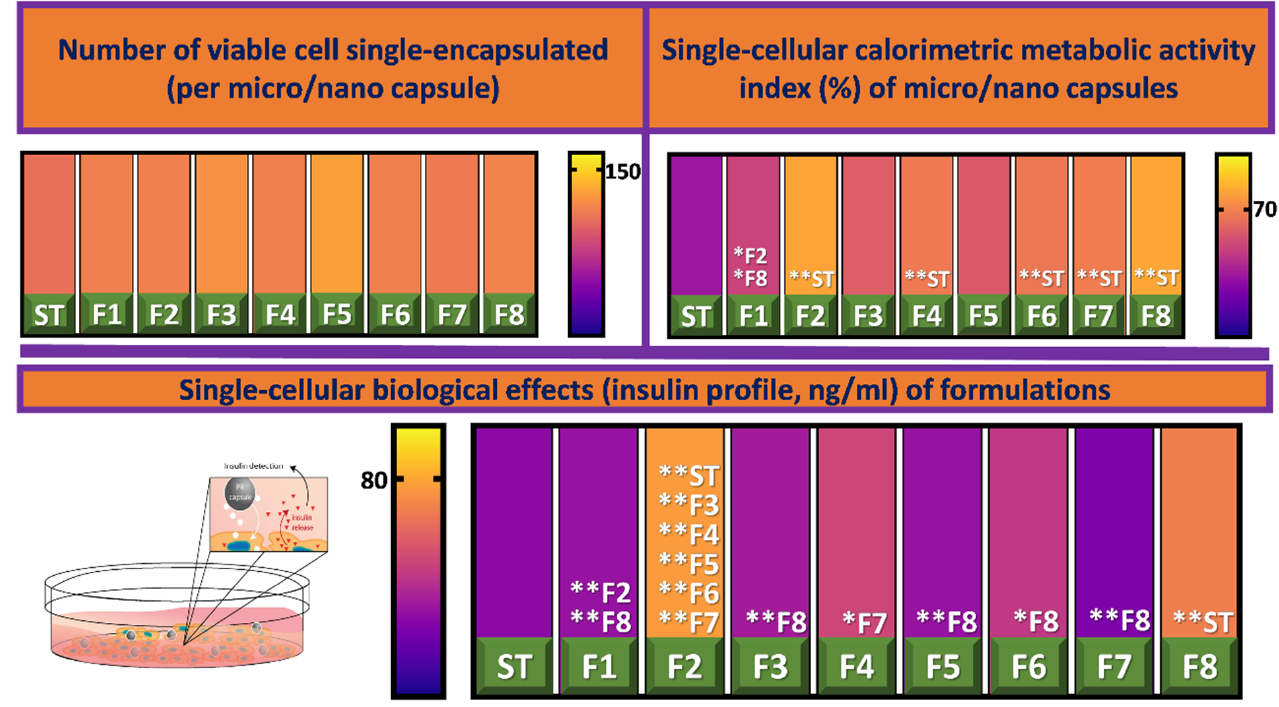
Figure 2. Cell viability ( top , left ), metabolic activity ( top , right ), schematic representation of experimental theory ( middle ), and insulin profile ( bottom ). Data are mean ± standard error of the mean, n = 3. Singular asterisk denotes where p < 0.05, whereas double asterisk denotes p < 0.01.